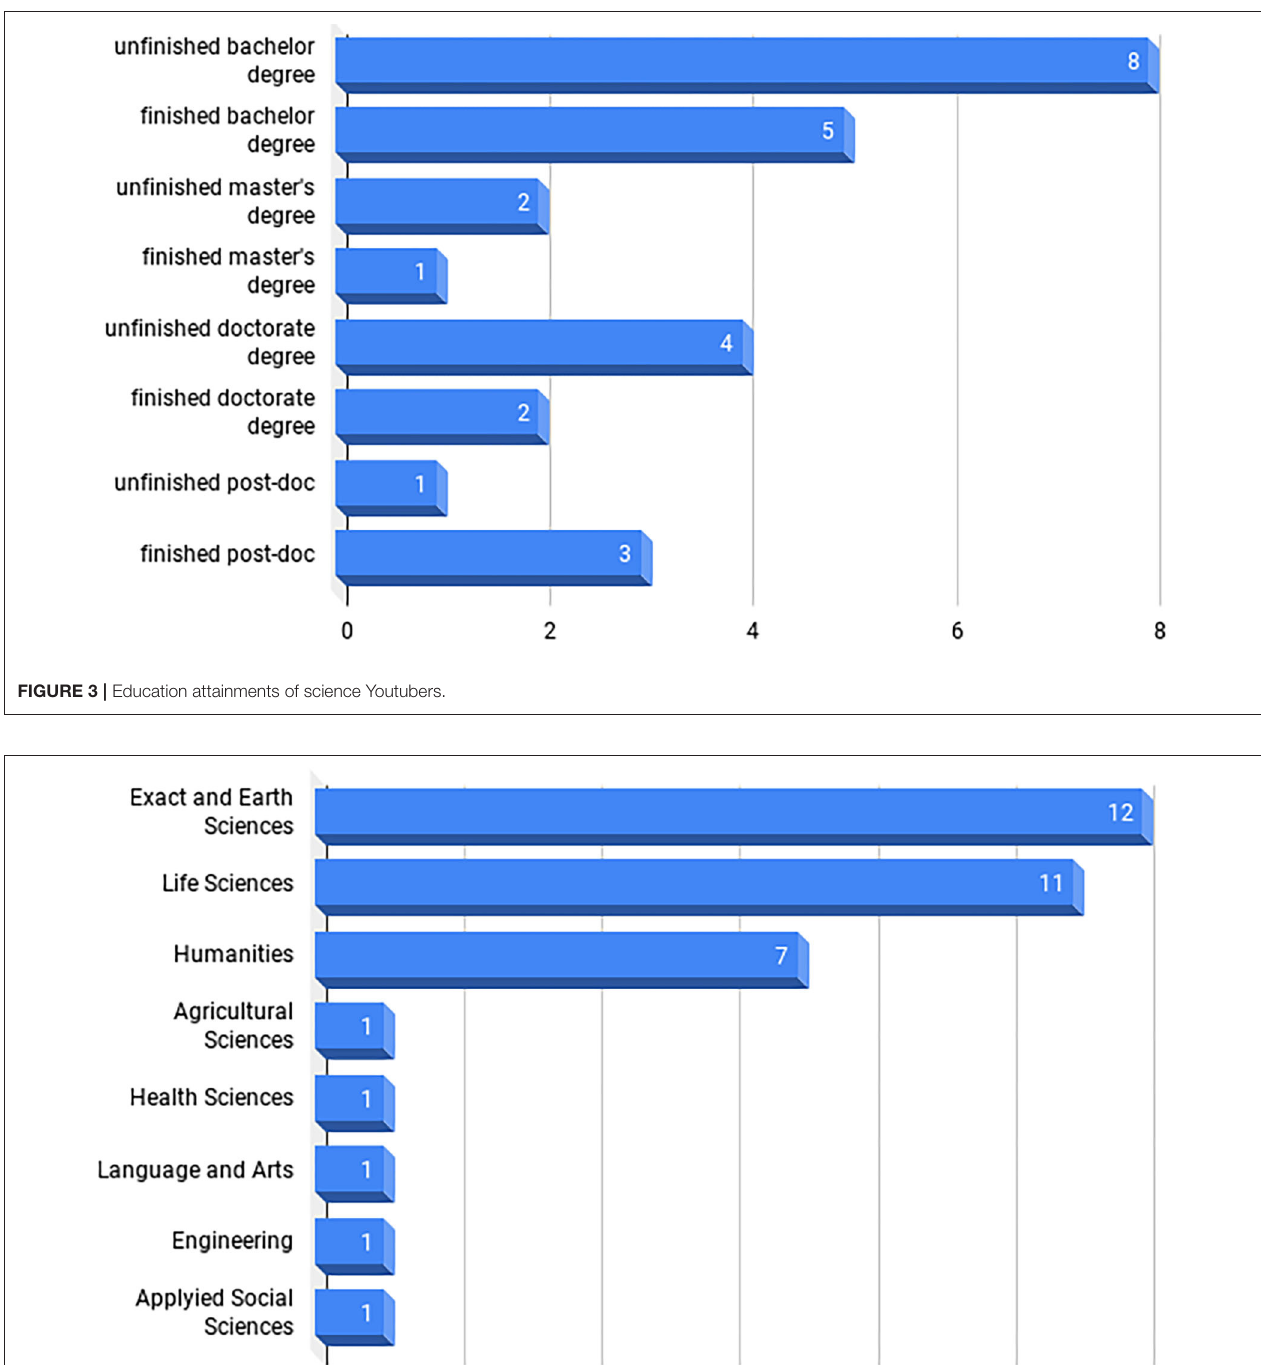
remaining did not specify. At least half of the YouTubers have more than one occupation. The most common scenario is working as a teacher and having another occupation, such as